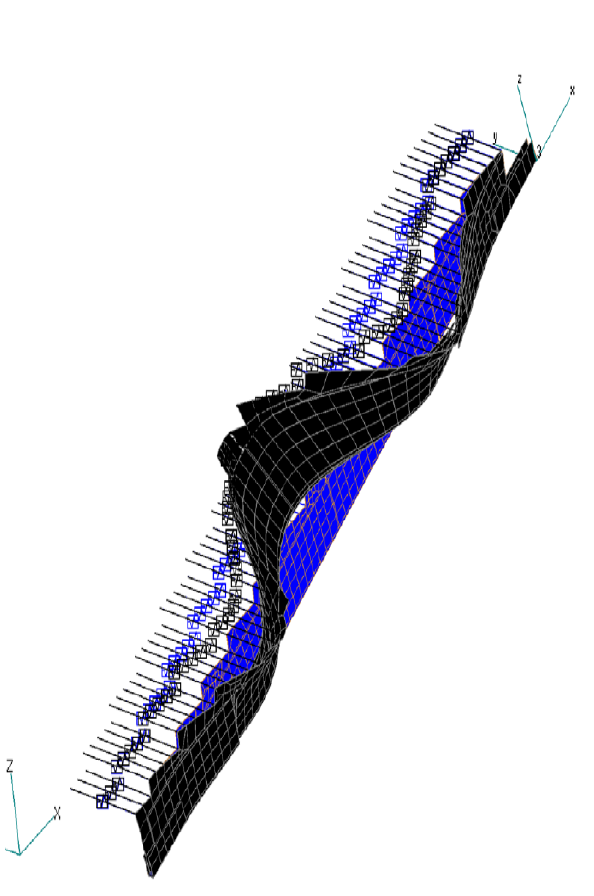
Figure 5: Finite element analysis of buckled shape